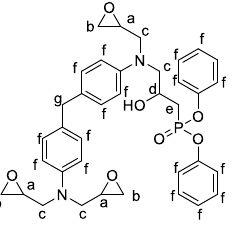
Figure 14. MBDA-DPP structure.